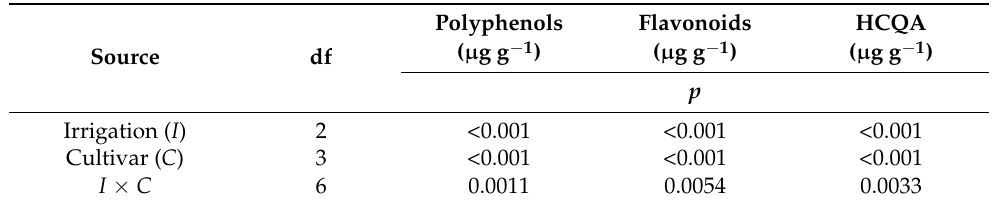
Table 3. ANOVA results for polyphenols, flavonoids, and HCQA content, in four cultivars of tomato in relation to the irrigation treatments. Degree of freedom (df).